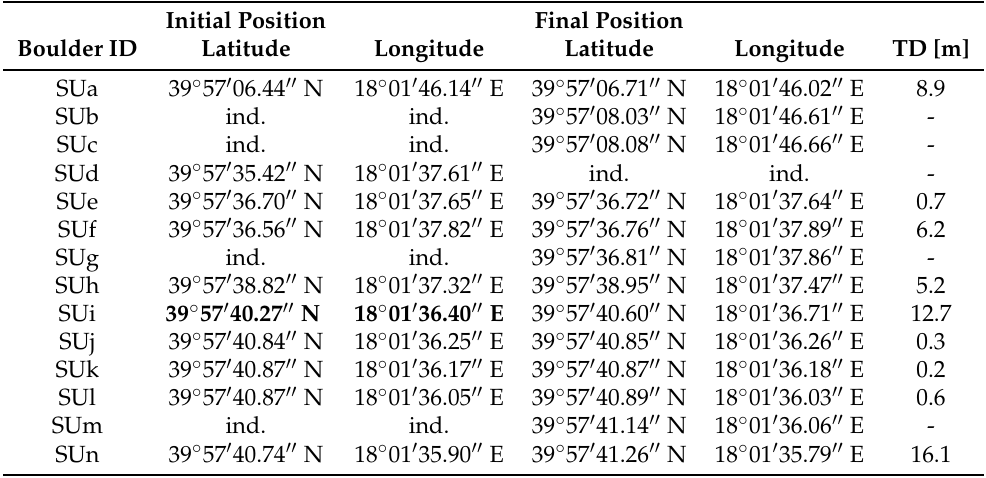
Table A9. Initial and final geographical coordinates of the displaced boulders at the Torre Suda coast; ind., indeterminable.